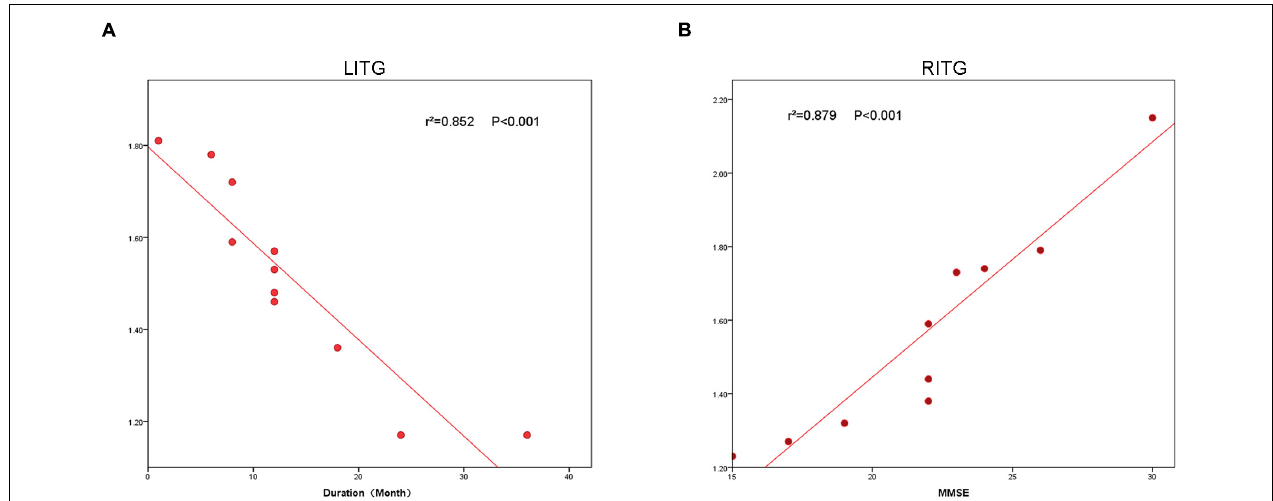
FIGURE 4 | The correlation between the ReHo value of LITG, RITG and the duration (A), and MMSE (B) . In the Alzheimer’s disease group, the ReHo value of LITG showed a negative correlation with duration ( r 2 = 0.852, P < 0.0001). The ReHo value of the RITG was positively correlated with MMSE ( r 2 = 0.879, P < 0.0001). ReHo, regional homogeneity; MCI, mild cognitive impairment.